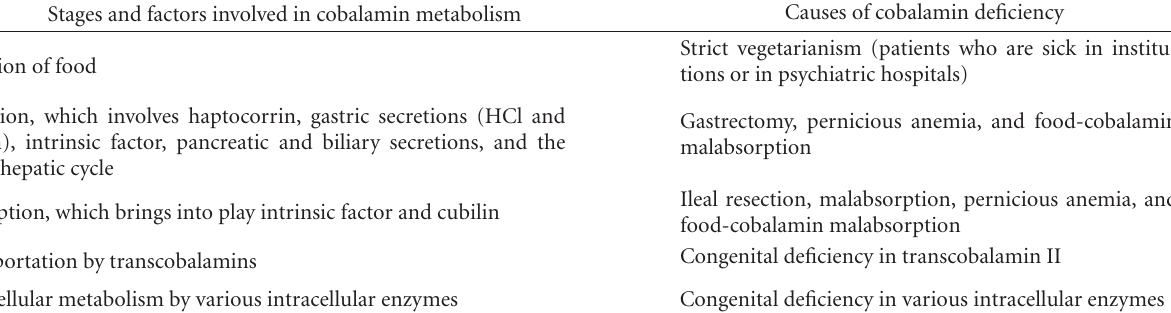
Table 2: Stages of cobalamin metabolism and corresponding causes of cobalamin deficiency [13, 15].